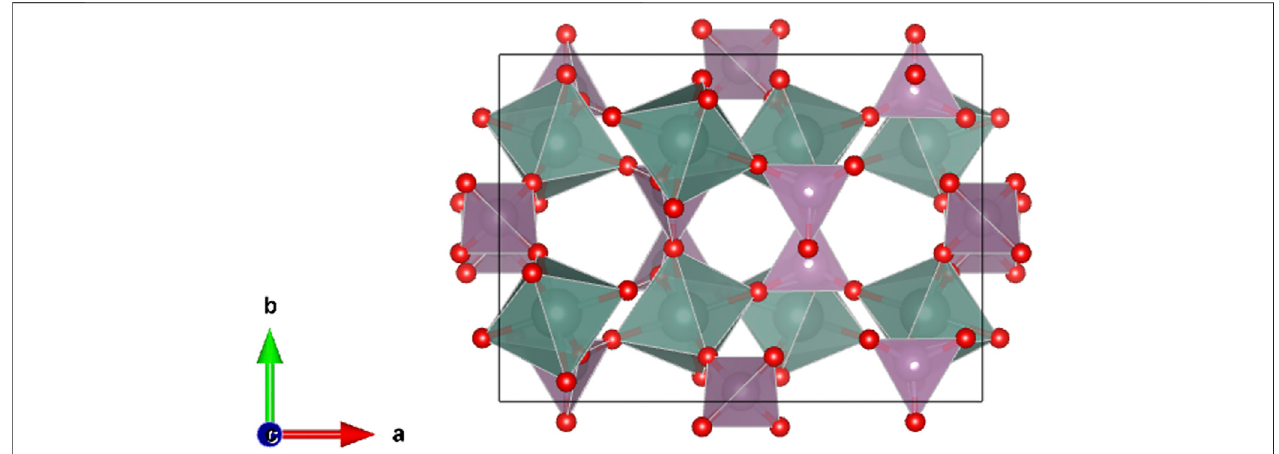
FIGURE1 | Sc 2 W 3 O 12 -type orthorhombic structure ( Pbcn space group), shown for Y 2 Mo 3 O 12 at room temperature, oriented along the c -axis direction, indicating void spaces due to vacant dodecahedral, 8-fold sites (which are fully occupied in the garnet